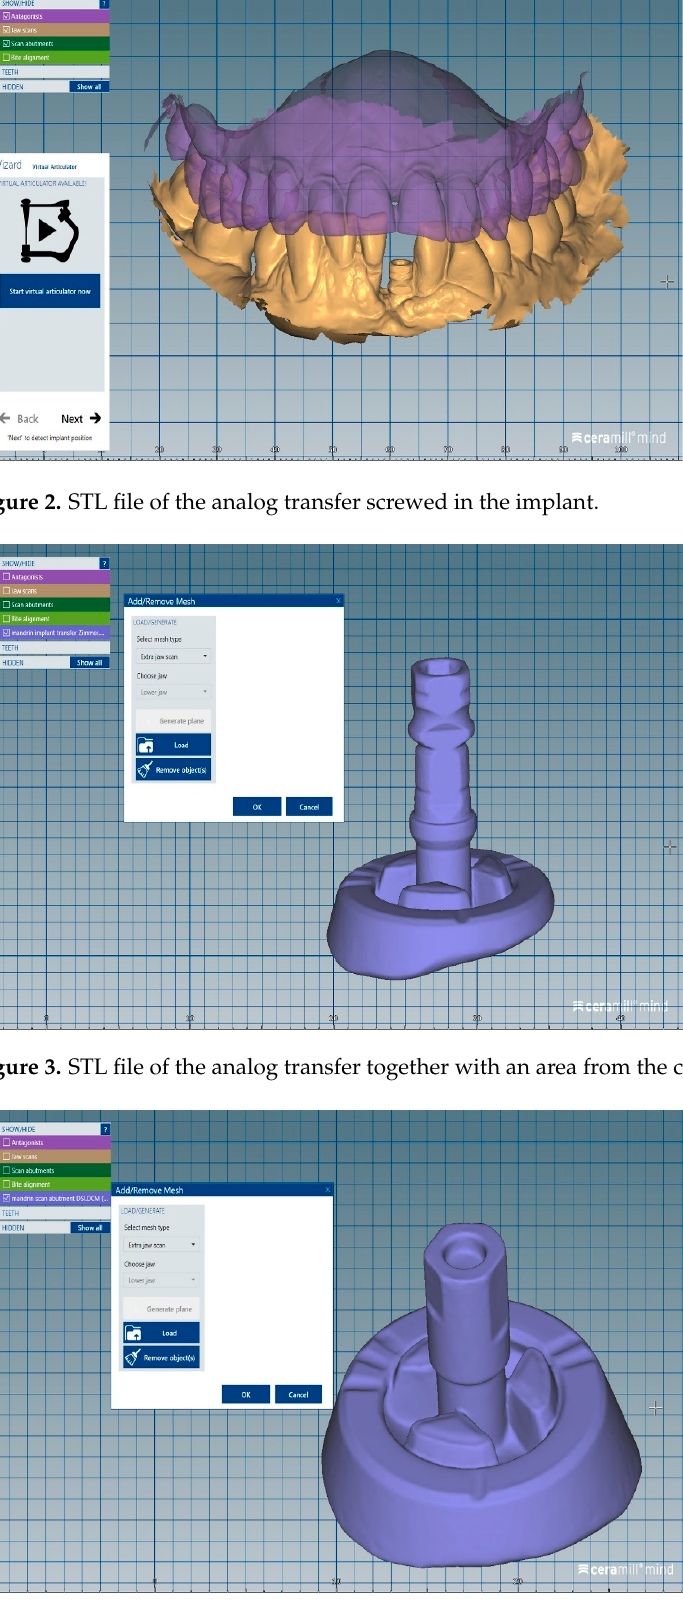
Figure 4. STL file of the scan body together with an area from the chuck. 9. Import into the Exocad order the STL files from point 5 as an “extrajaw scan,” which is used for indexing the visible part of the transfer abutment (Figure 5).